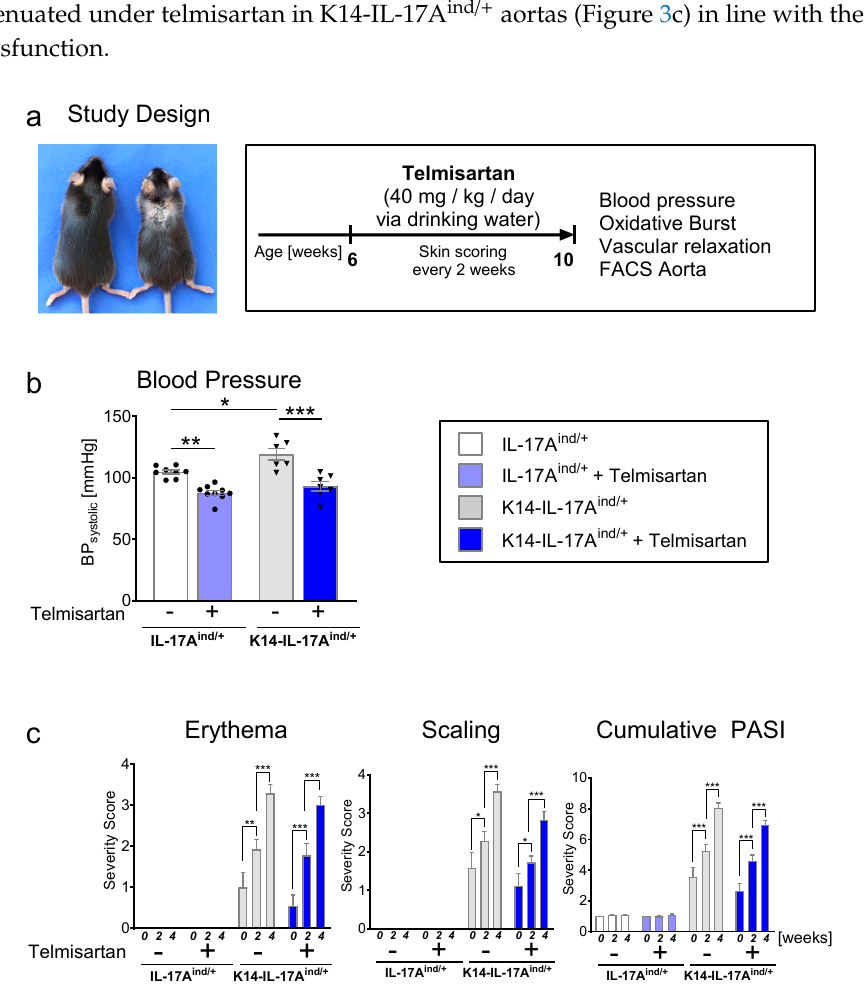
Figure 1. Telmisartan treatment lowers blood pressure in mice with severe psoriasis-like skin disease with no impact on skin disease. ( a ) Representative picture of a healthy control mouse and a K14-IL-17A ind /+ mouse (first published by Croxford et al. [15]) and description of the experimental design of our study. ( b ) Systolic blood pressure (BP) recordings by tail-cu ff after four weeks of telmisartan treatment in K14-IL-17A ind /+ and control mice, n = 6–9, one-way ANOVA with Bonferroni’s post-test. ( c ) Erythema and scaling were scored in K14-IL-17A ind /+ and control mice with and without telmisartan treatment. Cumulative Psoriasis Area and Severity Index (PASI) score calculated. n = 6–9, two-way analysis of variance with Bonferroni multiple comparisons test. The p-values of ≤ 0.001, ≤ 0.01, and ≤ 0.05 were considered statistically significant and marked by three, two, and one asterisks, respectively, ns = not significant. All data are presented as mean ±